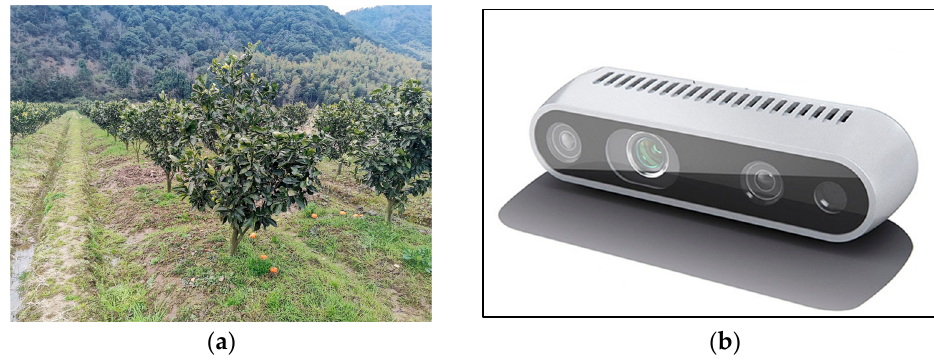
Figure 1. Equipment used: ( a ) citrus plantation, ( b ) image acquisition equipment.